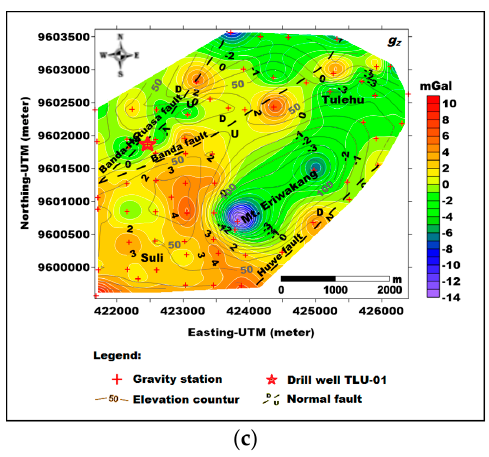
Figure 12. The gravity field components of Suli and Tulehu areas in Cartesian coordinate system ( a ) g x ; ( b ) g y ; ( c ) g z .